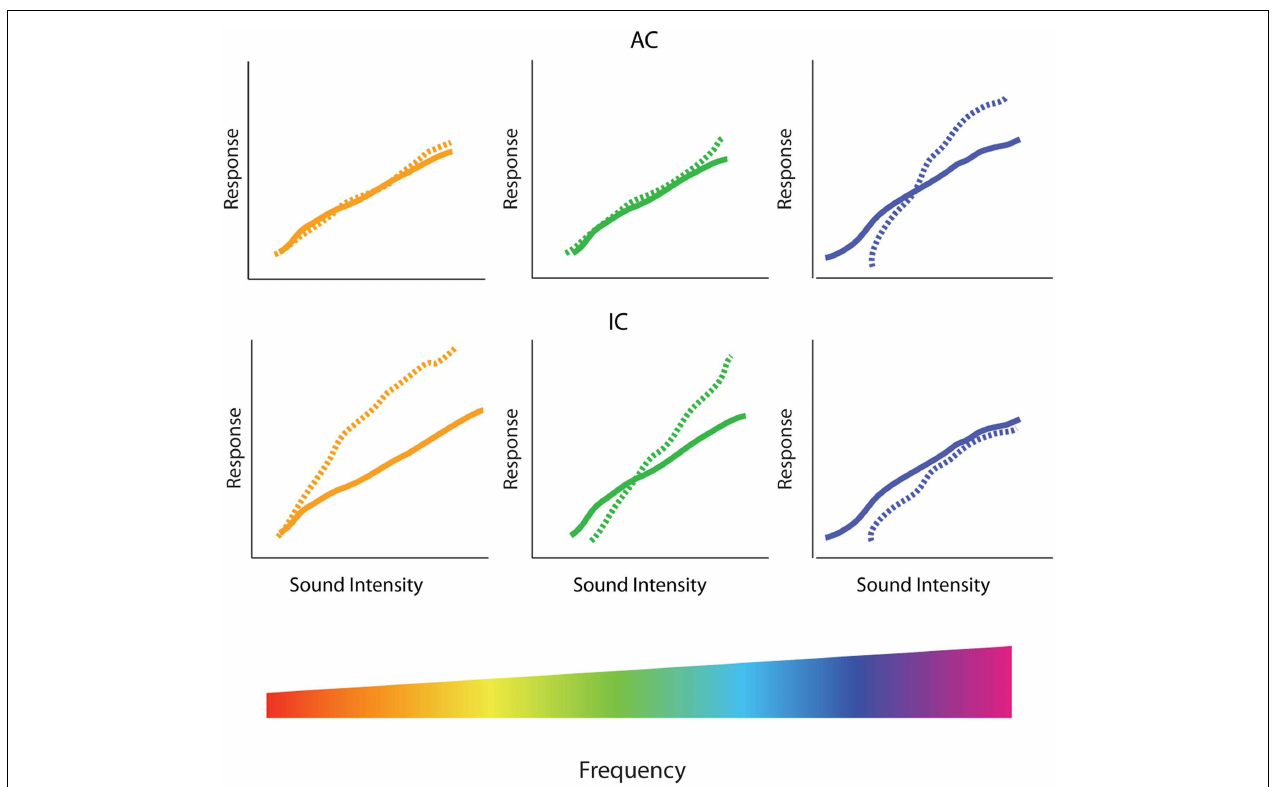
IC, high-frequency hearing loss results in increased threshold and depressed amplitude-level functions in the tonotopic region corresponding to the region of hearing loss (blue), while suprathreshold responses are enhanced at low and middle frequencies (orange and green, respectively). (Top) In contrast, amplitude-level functions from the AC are enhanced in the region of hearing loss (blue) while relative unchanged at low (orange) and middle (green)